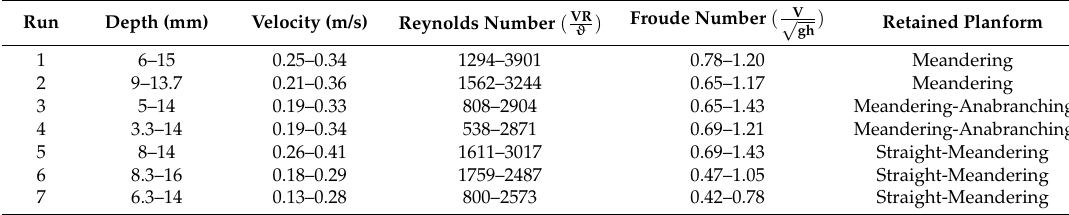
Table 2. Experimental parameters.